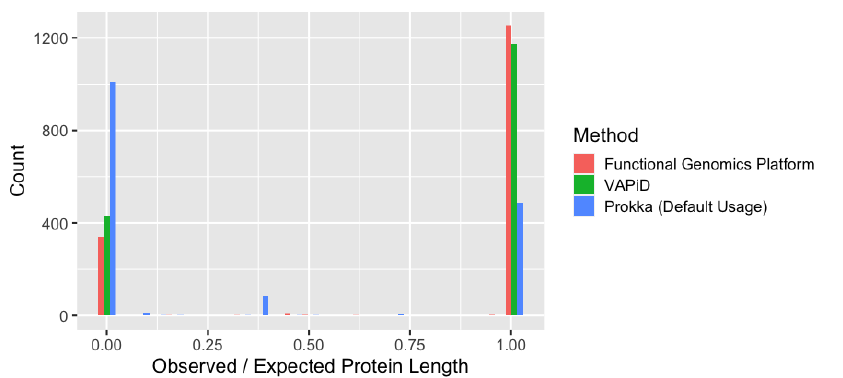
Figure 5. Protein length comparisons against known reference sequences for three pipelines: Func- tional Genomics Platform (our method), VAPiD, Prokka with default usage for viral genomes. The count of protein sequences at each observed/expected value is plotted for each pipeline. Length is set to zero if a protein is missing in the results from that pipeline but present in